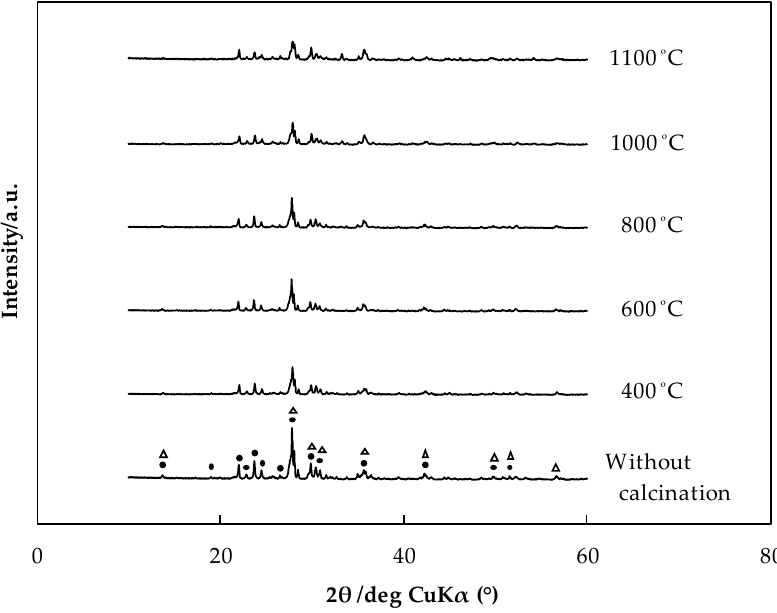
Figure 9. X-ray diffraction (XRD) patterns of JB-1a calcined at various temperatures ( ● : albite calcian; △ : augite; CuK α ; scan rate: 10°/min; and step scan size: 0.02°).